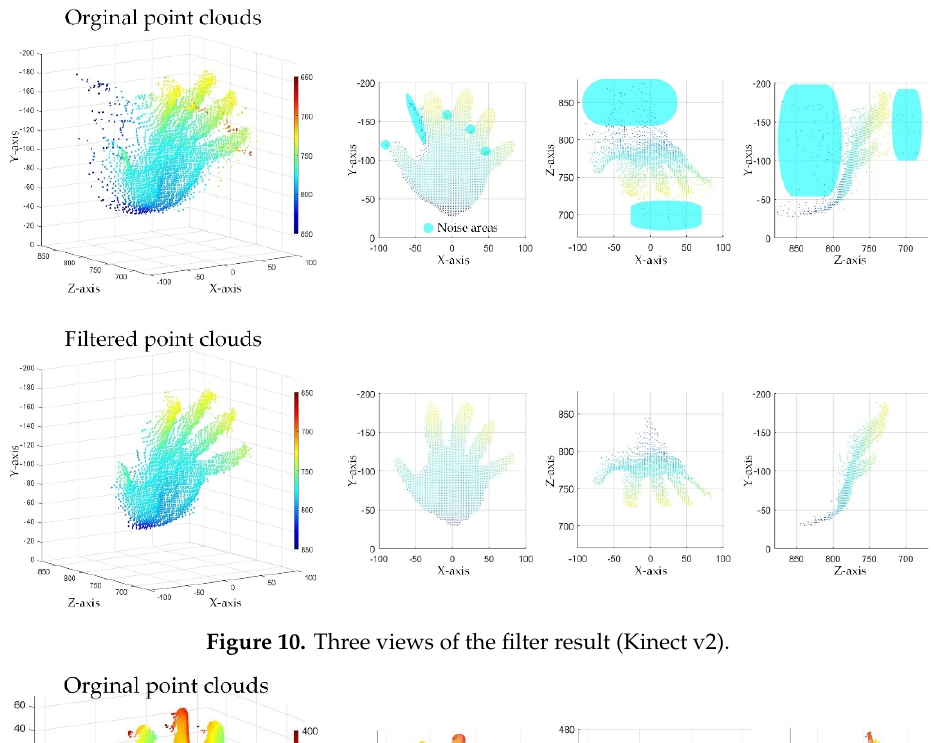
Figure 10. Three views of the filter result (Kinect v2).